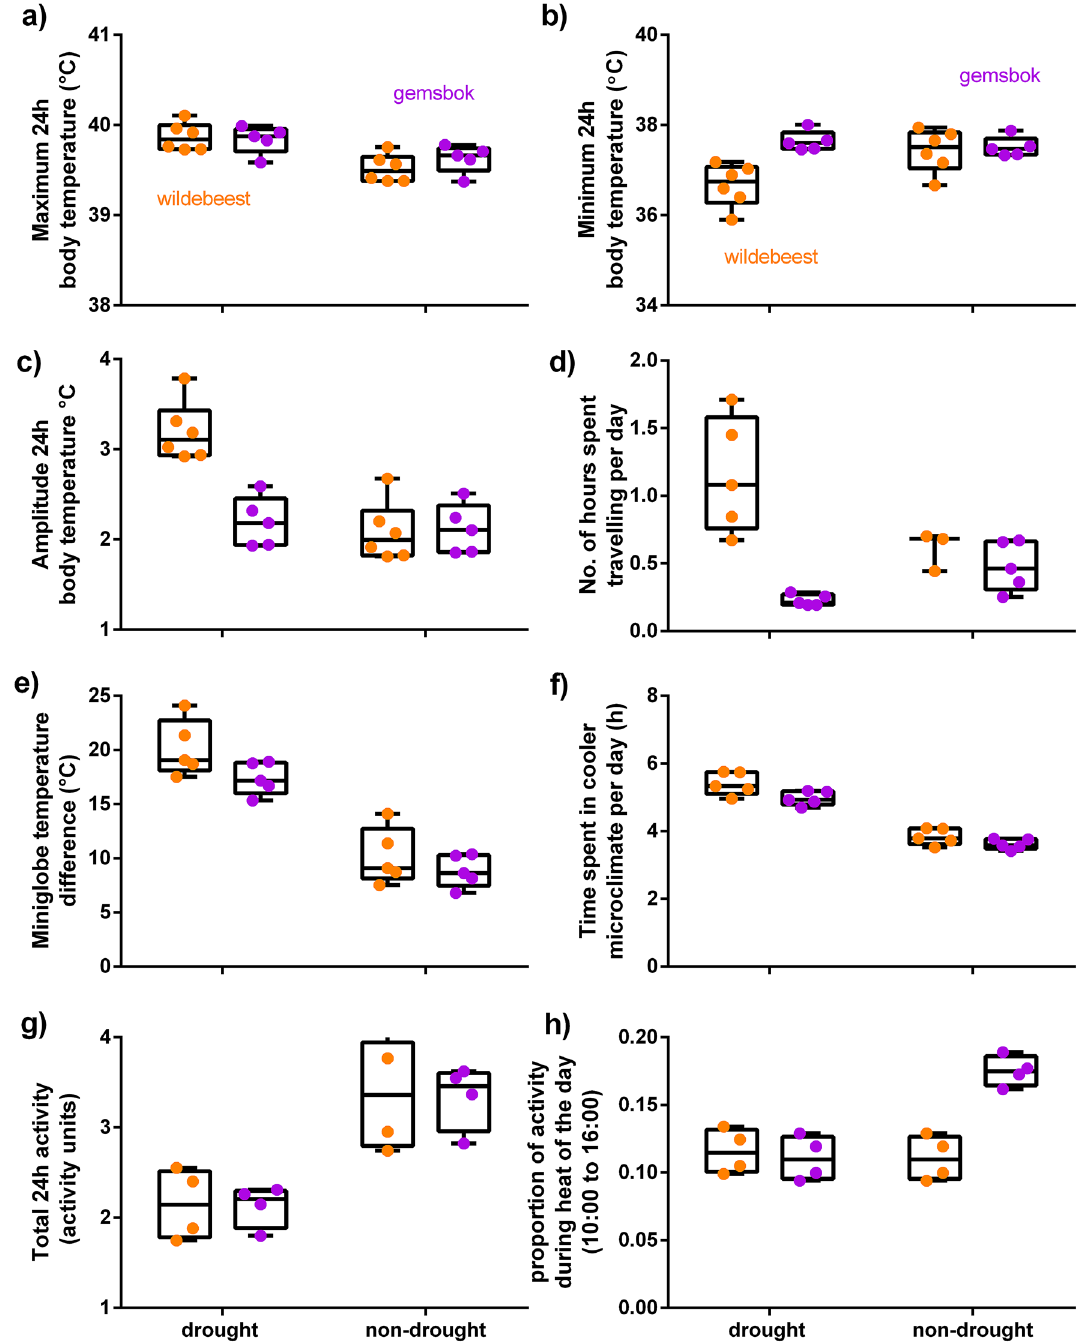
Figure 2. Predictive margins with 95% CIs for the Generalised Linear Mixed Model results for the association between season and species in terms of body temperature profiles ( a – c ), number of hours spent travelling per day ( d ), cumulative microclimate use ( e ) and time spent in cool microclimates ( f ) per day, total 24 h activity ( g ) and the proportion of activity that took place during the heat of the day (10:00 to 16:00) ( h